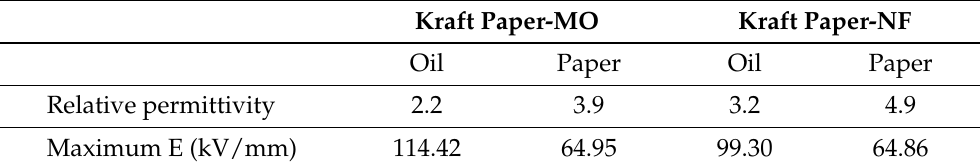
Table 4. Maximum electric field in paper and oil for a testing voltage of 5.5